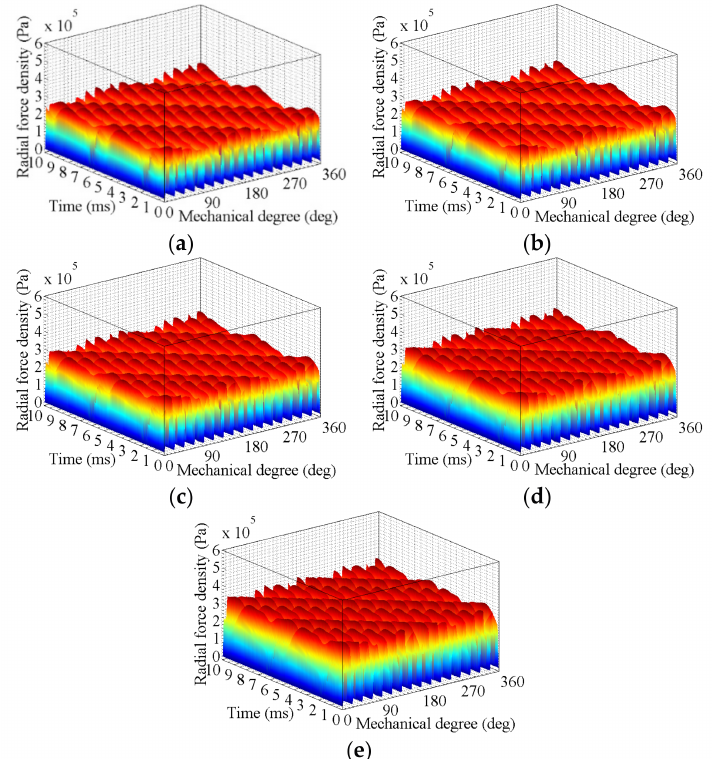
Figure 11. Radial force density in the IPMSM with rotor deformation at no-load condition. ( a ) es = 0 mm; ( b ) er = 0.1 mm; ( c ) er = 0.2 mm; ( d ) er = 0.3 mm; ( e ) er = 0.4